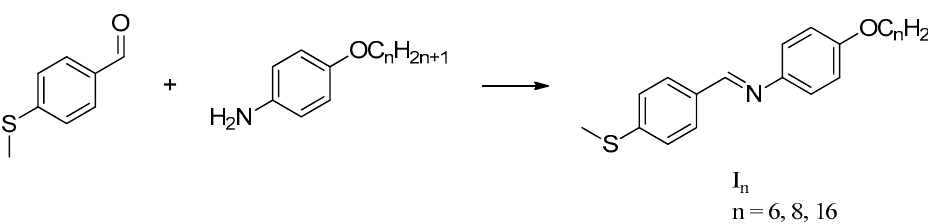
Figure 2. Nematic texture of I 8 derivative upon cooling round at 99 °C under POM. Table 1. Transition temperatures (°C), enthalpy in kJ/mol, and normalized entropy of transitions for series I n . Comp.